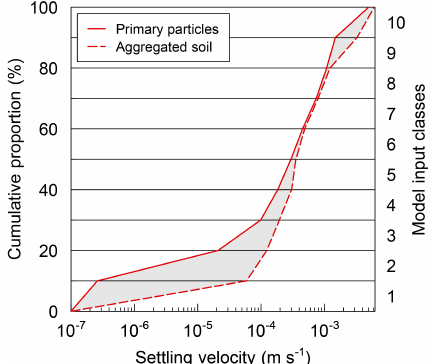
Figure 2. Measured cumulative proportion of settling velocity dis- tributions for primary particles and aggregated sediments ( n = 81). The grey area represents the range of possible settling velocities re- lated to different proportions of primary particles or soil aggregates. Right y axis shows the settling velocity classes as implemented in the model for primary particles and aggregates (based on par- ticle size distribution measurements conducted by Beuselinck et al.,